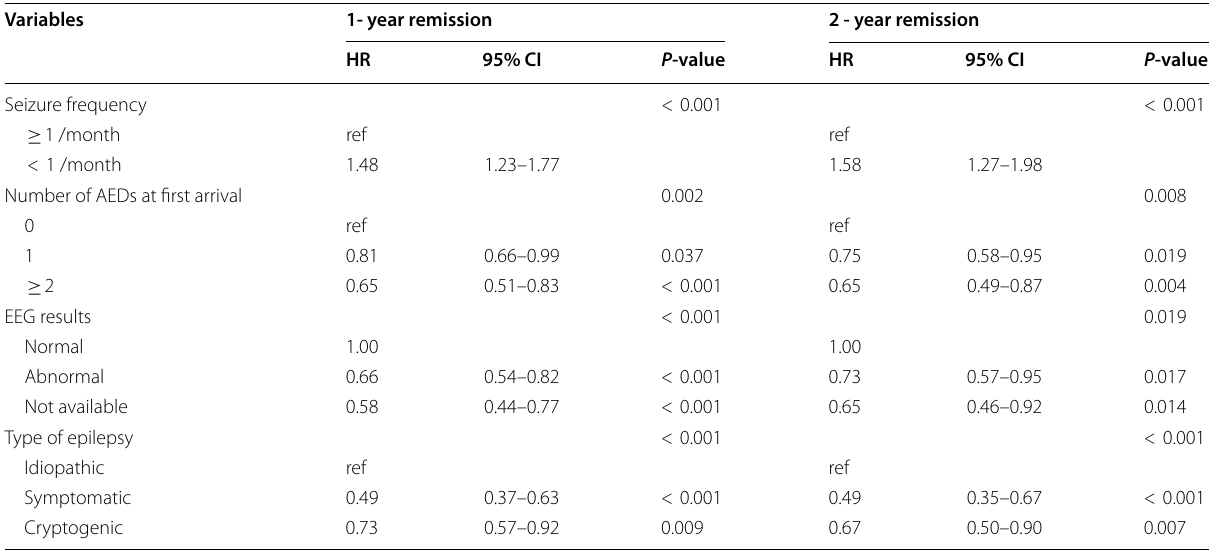
Table 2 Variables found to correlate with the first 1-year and 2-year remissions in multivariate Cox proportional hazard analysis